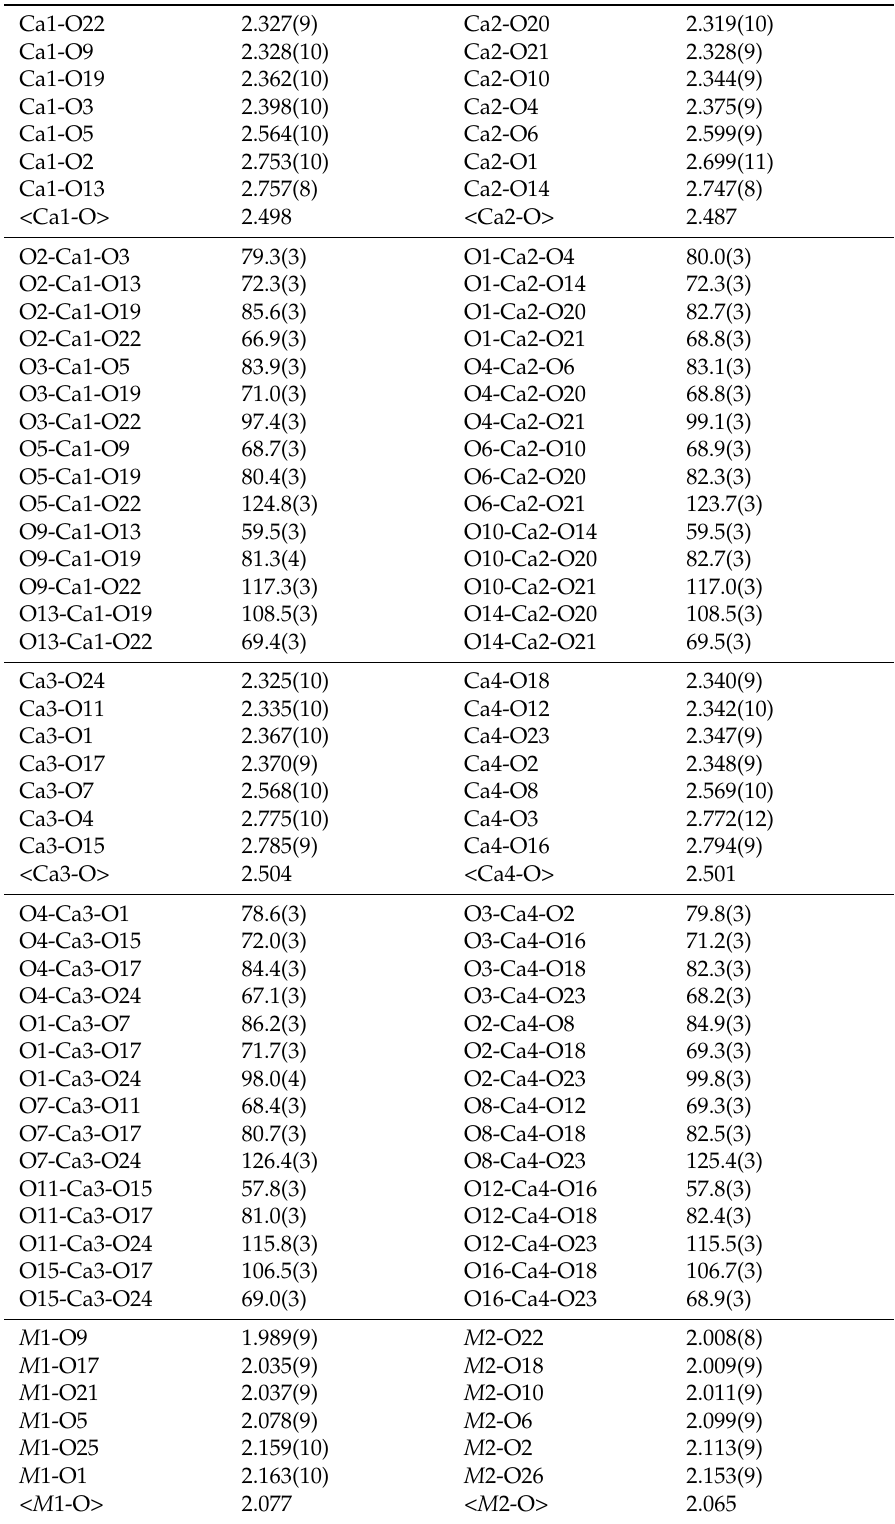
Table 4. Bond lengths (Å) and bond angles ( ◦ ) for